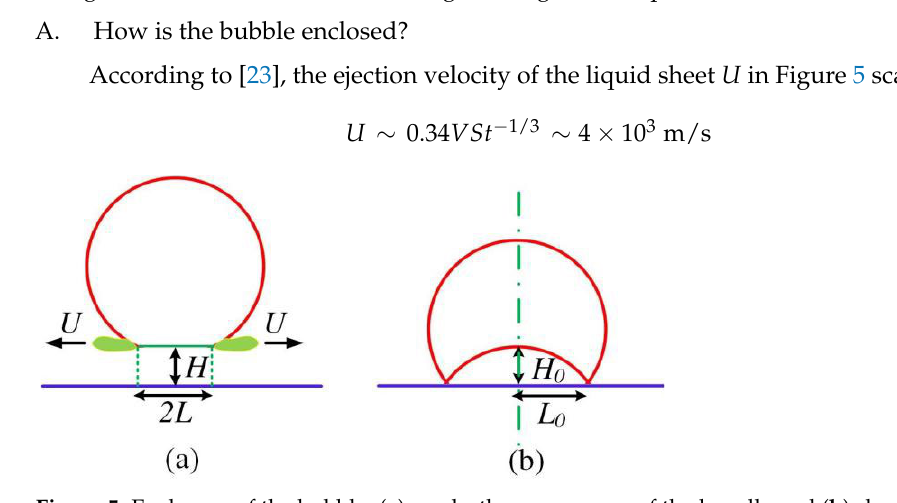
Figure 5. Enclosure of the bubble. ( a ) marks the appearance of the lamella and ( b ) shows when the lamella touches the substrate for the first time.